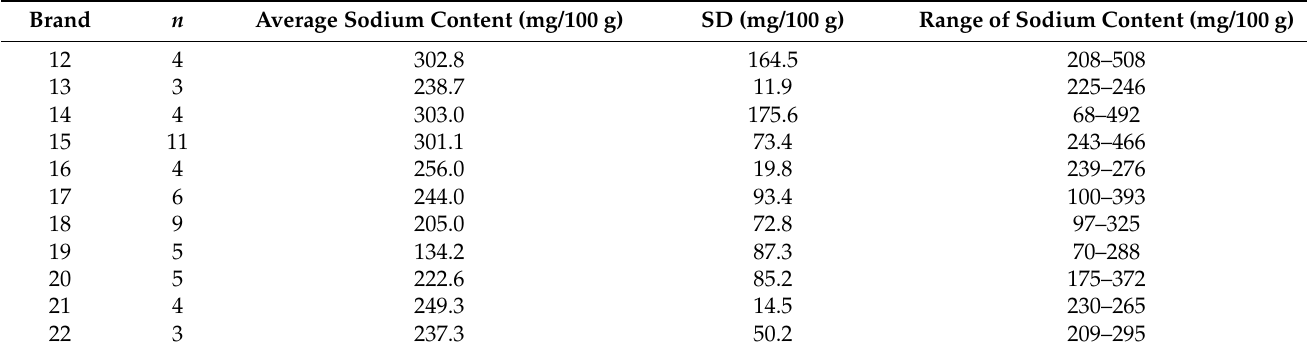
Table 4. The sodium content in 11 different brands of